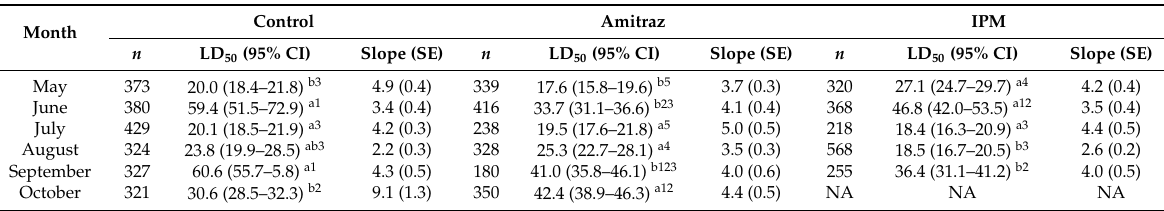
Table 2. Honey bee amitraz bioassay summary. The LD 50 values are in shown in units of ng amitraz/mg bee. The LD 50 values were considered significantly different if the 95% CI of the LD 50 values did not overlap between colonies or test dates. Letters and numbers beside LD 50 values indicate significant differences in rows and columns, respectively. The LD 50 value for the IPM treatment group in October was not reported as the data were not well represented by a line.